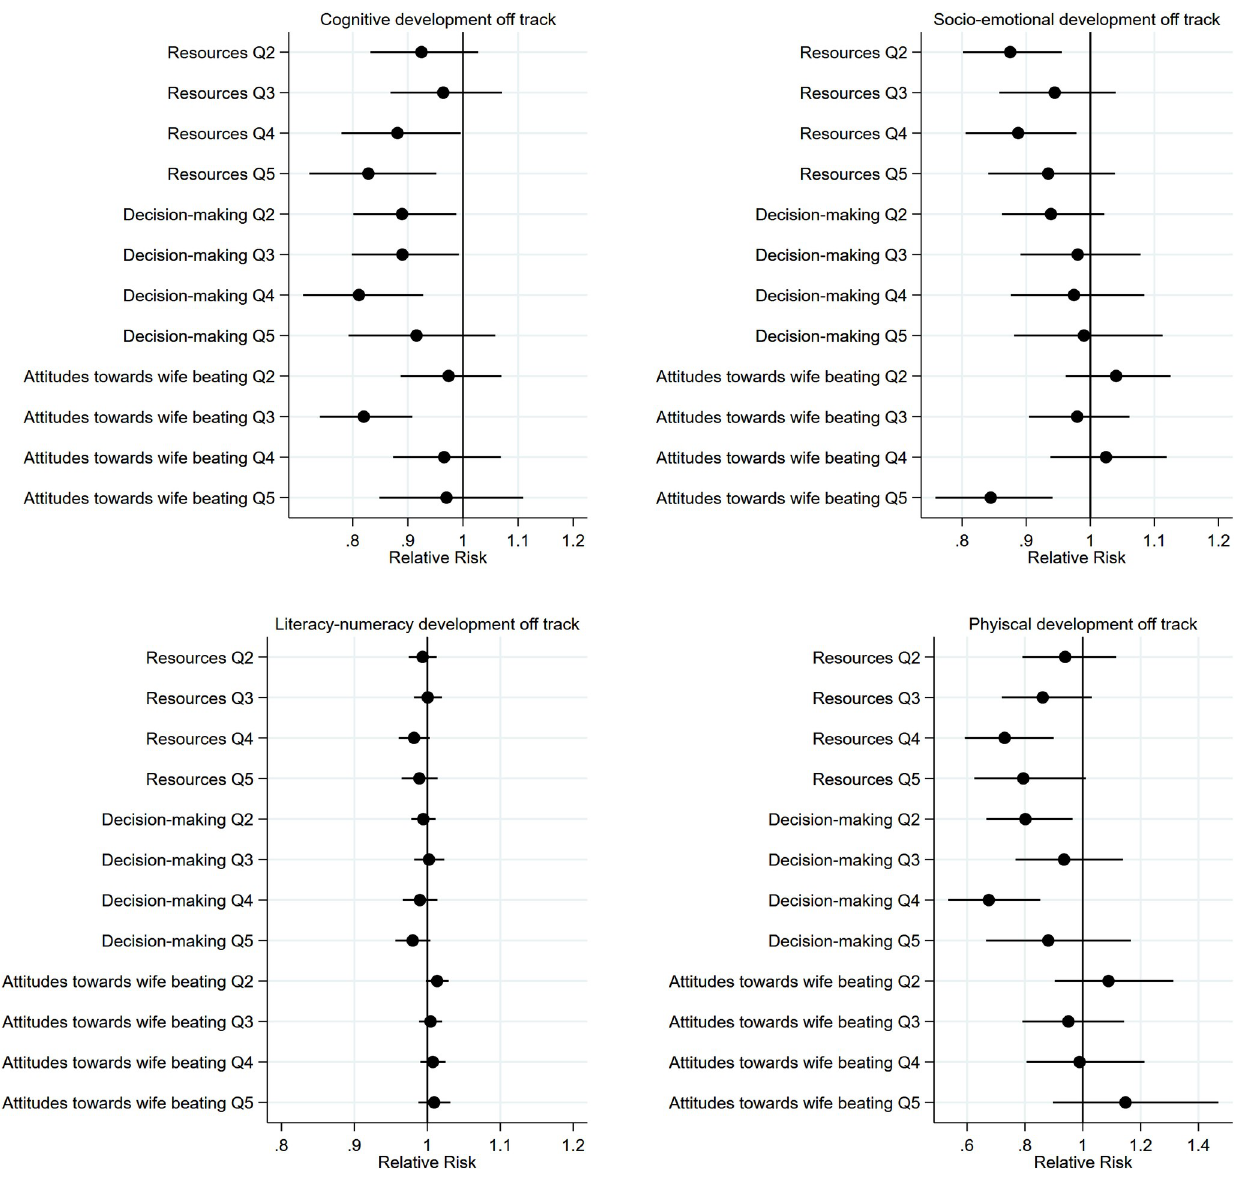
Fig 2. Associations between quintile categories of women’s empowerment dimensions and child development outcomes. All estimates accounted for clustering and representativeness using country-specific cluster variables and sampling weights and controlled for household wealth, rurality, and size; household head’s age and sex; maternal education, age, and age at first cohabitation; child age and sex; and country and survey year. Reference quintile category is Q1, lowest. Q, quintile category.